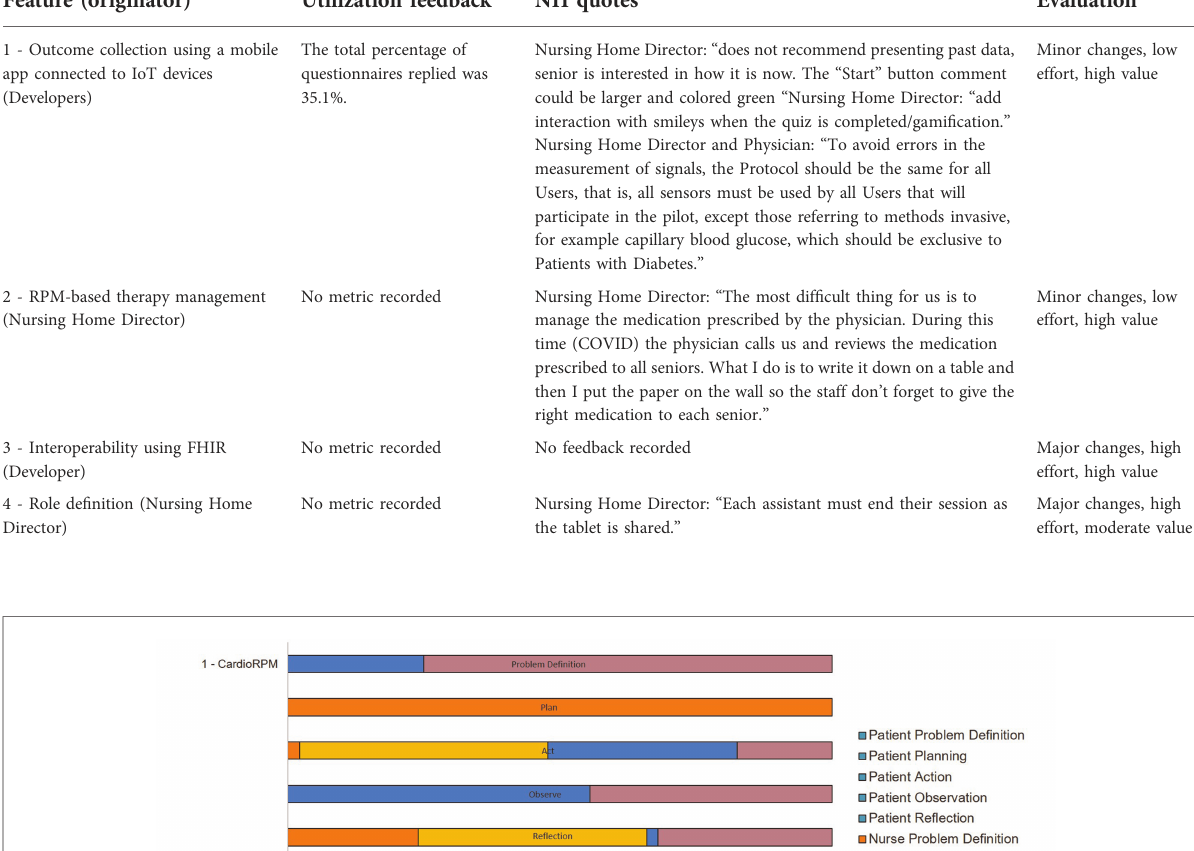
TABLE 5 List of features of pilot initiative 3.